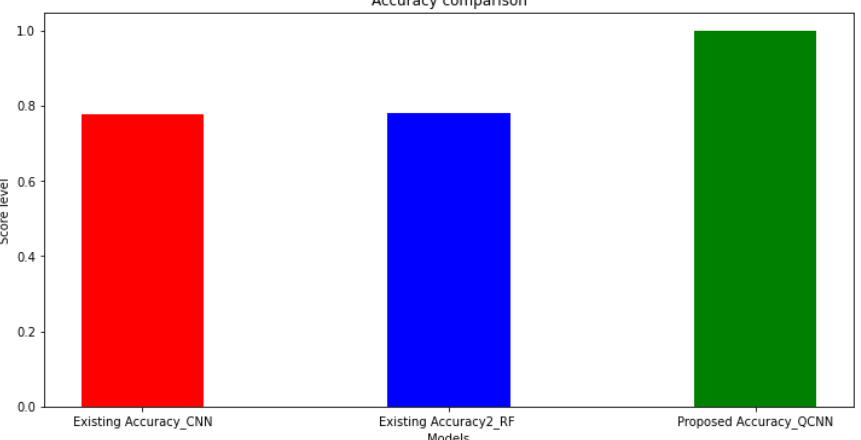
Figure 8. Accuracy comparison for the proposed method.